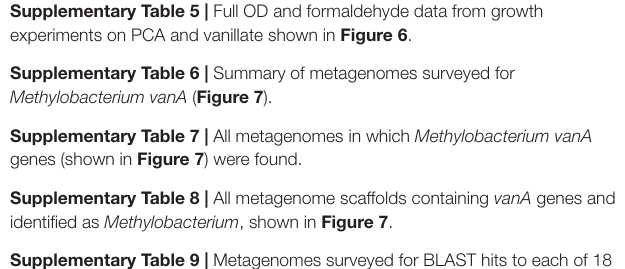
Supplementary Figure 1 | IMG phylogenetic lineage annotations do not match pplacer phylogenetic placement of vanA genes. Supplementary Figure 2 | Phylogeny of all Methylobacterium and Methylorubrum strains included in this study, based on the rpoB gene. Supplementary Figure 3 | Phylogeny of vanillate monooxygenase ( vanA ) genes with other COG 4638 (phenylpropionate dioxygenase or related ring-hydroxylating dioxygenase, large terminal subunit) genes from M. nodulans , M. indicum NS230, M. aquaticum DSM 16371, M. pseudosasiacola , and M. extorquens PA1. Supplementary Figure 4 | Genomic context of aromatic catabolism genes pobA and ech in Methylobacterium species. Supplementary Figure 5 | Methylobacterium sp. AMS5 catabolic island has similar GC content and tetranucleotide composition to the rest of the genome. Supplementary Figure 6 | Ecological distribution of metagenomes surveyed for Methylobacterium reads, for comparison with Figure 8 . Supplementary Figure 7 | Methylobacterium sp. 4–46 grows on methanol only when lanthanum is provided. Supplementary Table 1 | Methylobacterium strains included in this study, and locus tags of genes analyzed. Supplementary Table 2 | Reference organisms included in Figures 1, 2, and locus tags of genes analyzed. Supplementary Table 3 | Growth data for Methylobacterium strains on diverse compounds, shown in Figure 5 . Time, incubation time in hours. Species, abbreviated strain name. Substrate, carbon substrate. Well, location of the replicate in a multiwell culture plate. OD, optical density at 600 nm. Supplementary Table 4 | Growth data for Methylobacterium strains on methanol, shown in Figure 5 . Time, incubation time in hours. Species, abbreviated strain